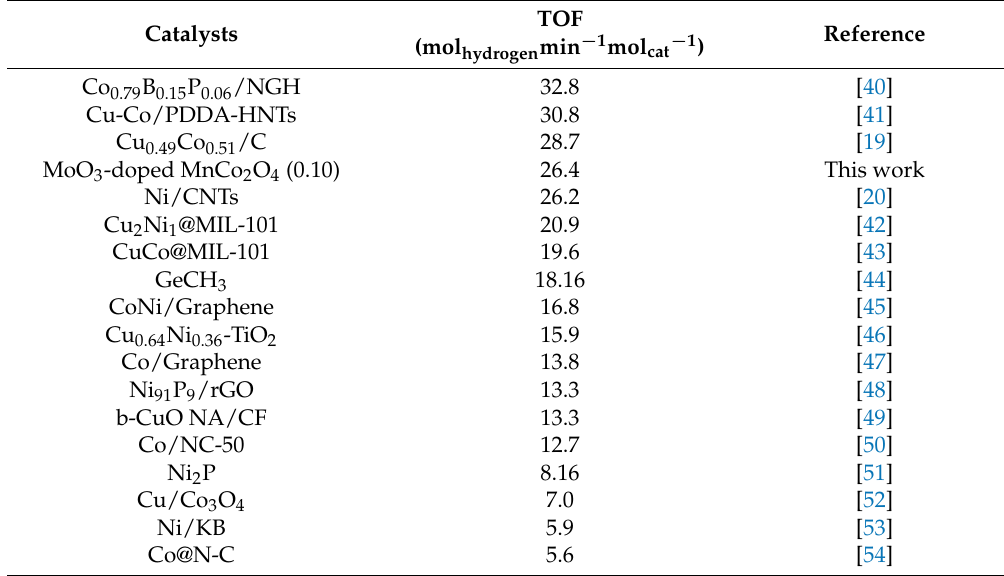
Table 2. Comparison the turnover frequency (TOF) of non-precious metal catalysts.